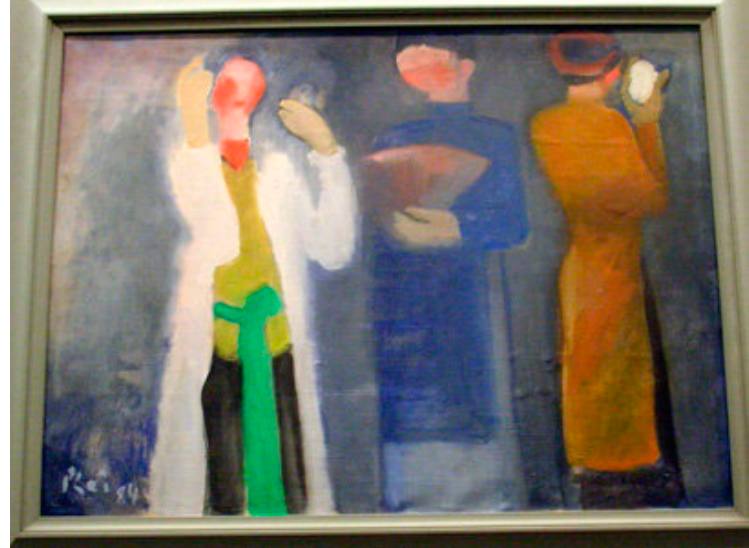
Figure A17. Truoc gio bieu dien (Cheo Actors)—Bui Xuan Phai. Hang at Vietnam Fine Arts Museum. The images were sourced from Tuoi Tre Newspaper (Ly 2008).